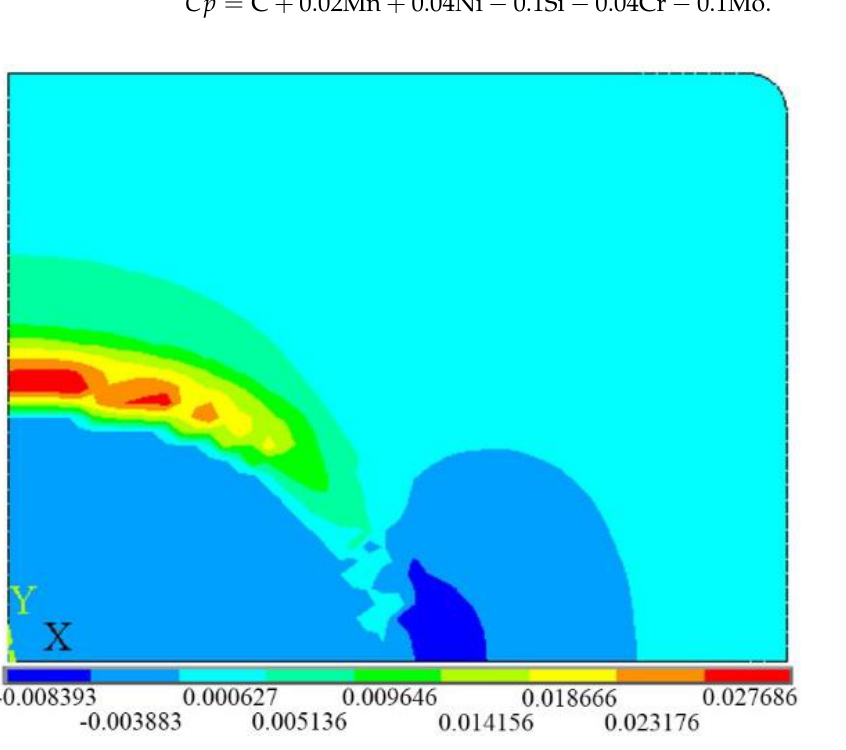
Figure 7. Simulation analysis of the strain of the solid shell for the opening point of the crack.